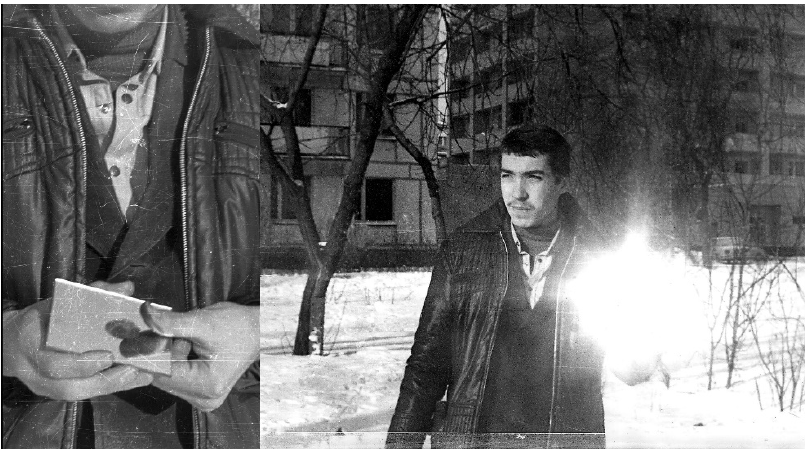
Figure 13. Zakharov. An Exchange of Information with the Sun . 1978. Black-and-white photograph. Image courtesy of Vadim Zakharov. Photograph by Yuri Albert.